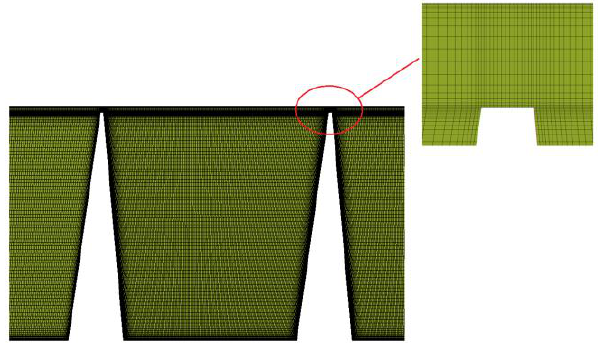
Figure 2. Details of the grid used in the simulation.